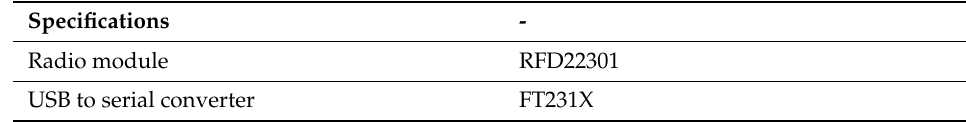
Table 3. Hardware speci fi cation of Siemens Simatic S7-300.